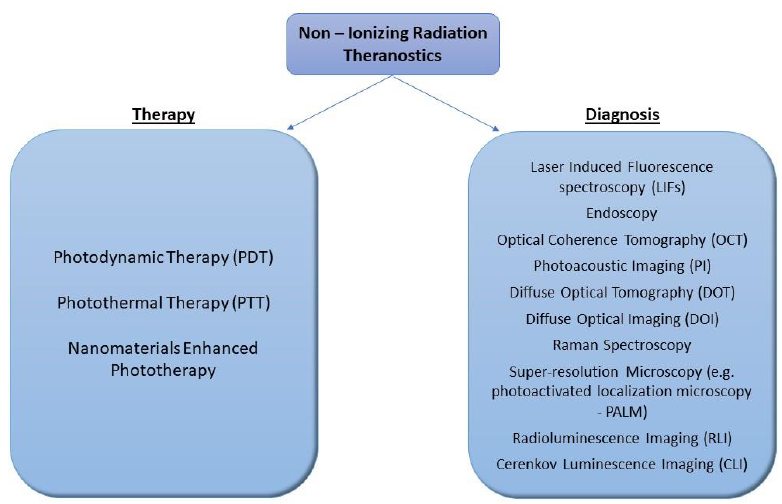
Figure 1. Schematic illustration of different uses of non-ionizing radiation theranostics in cancer treatment and diagnosis.